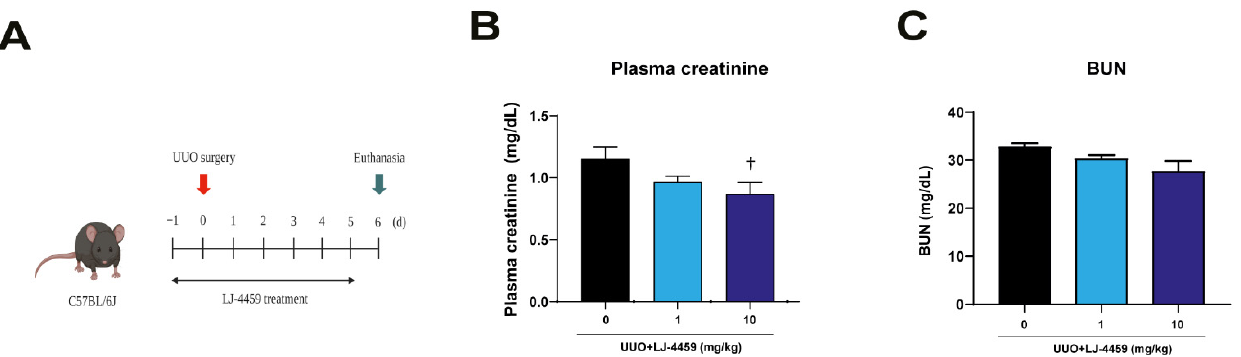
Figure 1. LJ-4459 improves kidney function in UUO mice. ( A ) Schematic diagram of the in vivo experimental schedule. Drug administration was start at 1 d before the UUO surgery, and mice were euthanized after 7 d of treatment. Plasma was analyzed for ( B ) plasma creatinine (mg/dL) and ( C ) BUN (mg/dL). Data are presented as mean ± SE of 7–8 mice. † p < 0.05 vs. UUO mice.